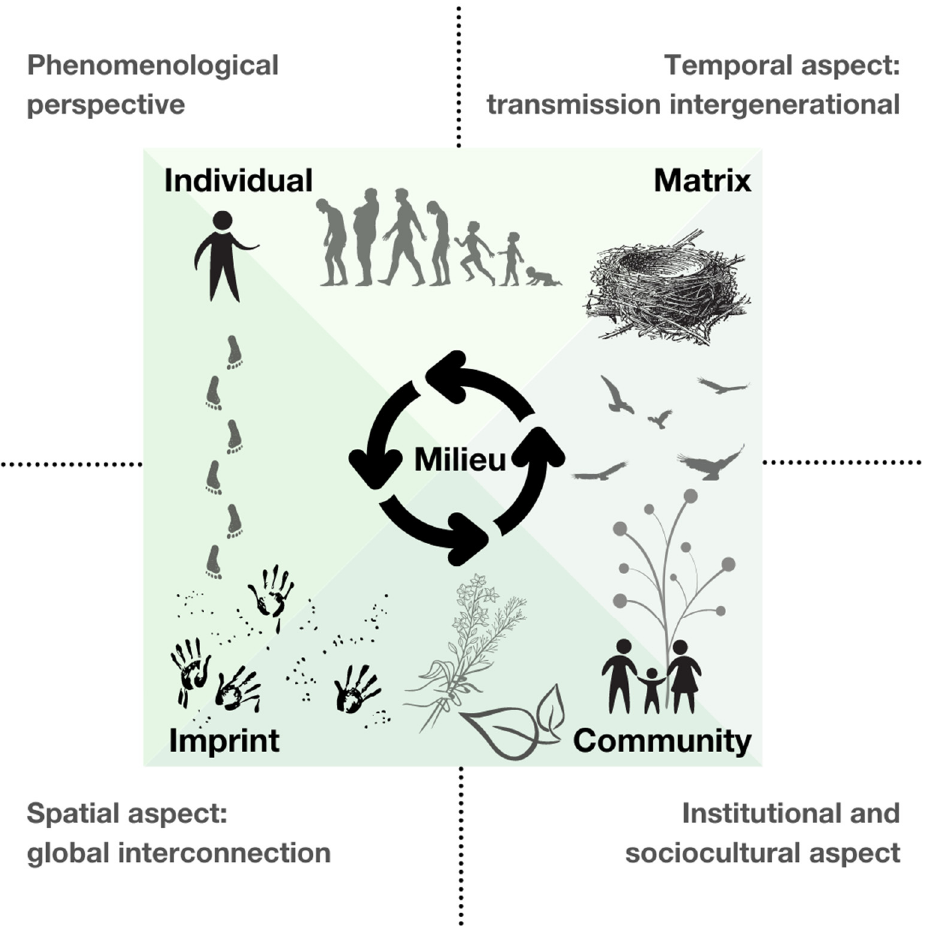
Figure 1. The framework of the milieu. Figure 1 sketches the framework of the milieu. It describes the relationships between the indi- vidual, the community and the milieu. The individual grows, acts and thinks from within the milieu as a matrix that nurtures, constrains and guides her. Most individual behaviours leave imprints on the milieu that maintain and change the milieu, together with the multiple imprints of the commu- nity who shares a particular milieu. Figure 1 synthesizes the phenomenological perspective of the individual who is influenced by and acts within the milieu (upper left); the spatial aspect of the global interconnection of the milieus that lead to distant consequences of individual imprints (lower left); the community and the institutional and sociocultural aspect of the milieu (lower right); the milieu as a matrix made of the countless influences of multiple human and nonhuman agents through time, and that, in turn, nurtures and constrains its inhabitants (upper right). Source: Original